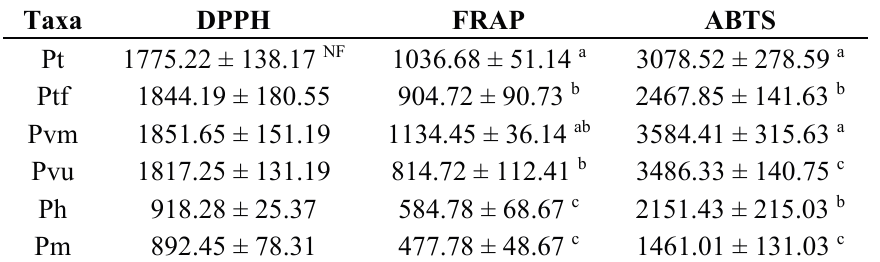
Table 2. Antioxidant activity determined by the DPPH, FRAP and ABTS assays of the needles extracts from the six Pinus taxa.